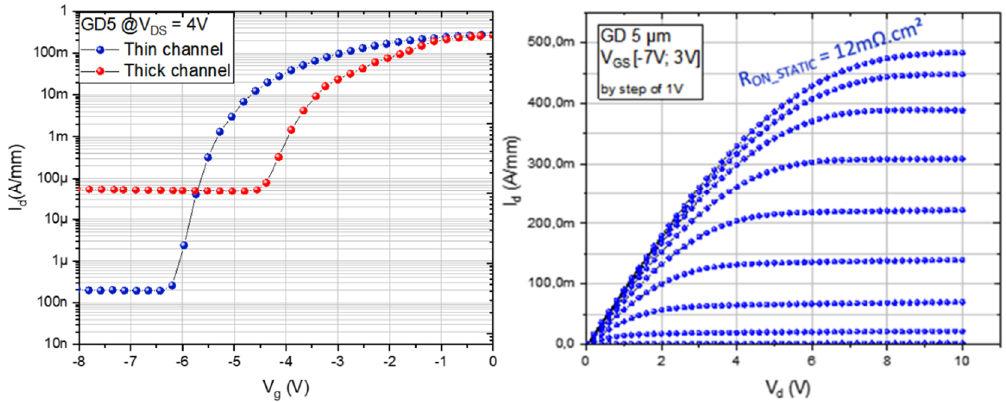
Figure 6. Transfer characteristics (left) for thin and thick channel structures and output characteristics (right) of the thin channel structure at RT.